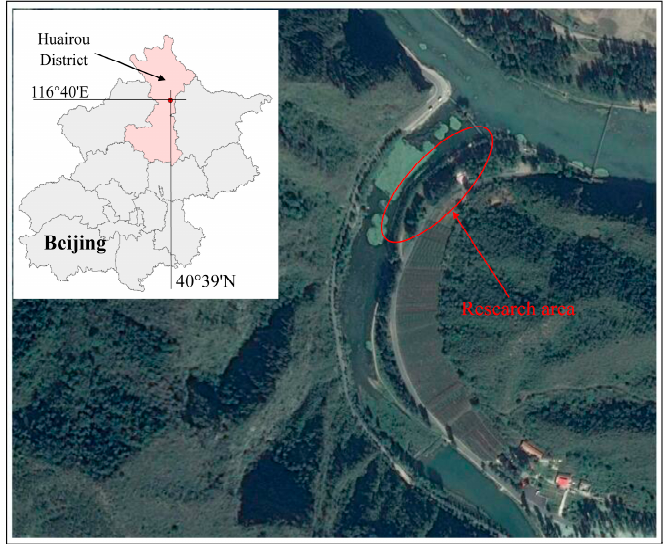
Figure 3. The location of the research area.